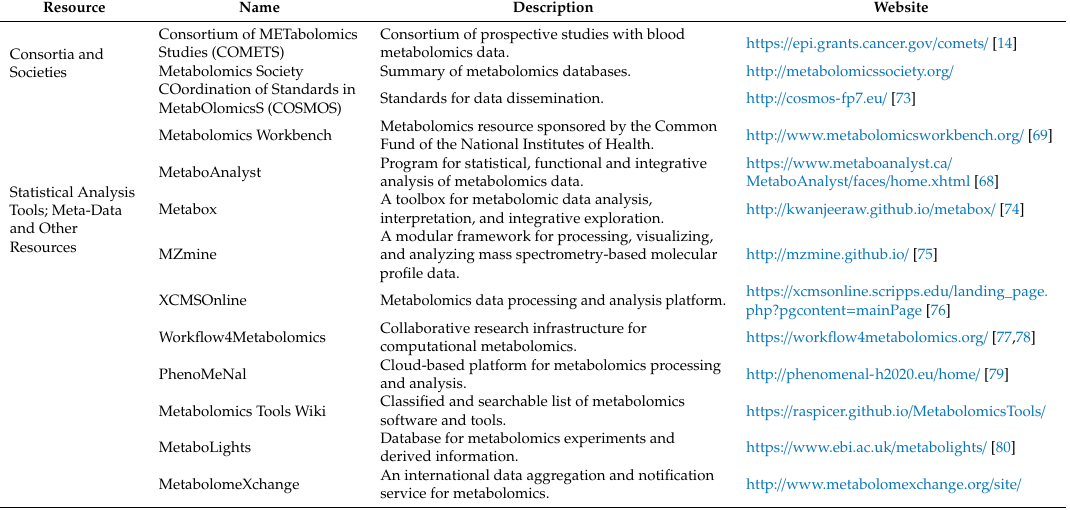
Table 1. Resources available for analysis and interpretation of metabolomics data. a